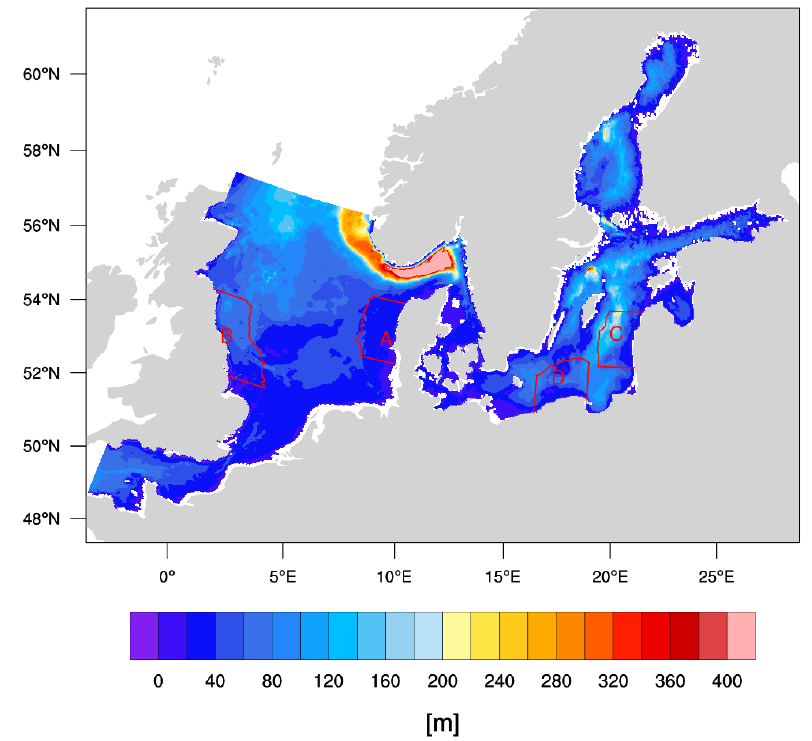
Figure 2. The domain of the Weather Research and Forecasting (WRF) is shown in the outer box. The colored area is the domain of Nucleus of European Modelling of the Ocean (NEMO) and WaveWatch-III (WW3), where the color represents the topography information in the wave and ocean model (unit: